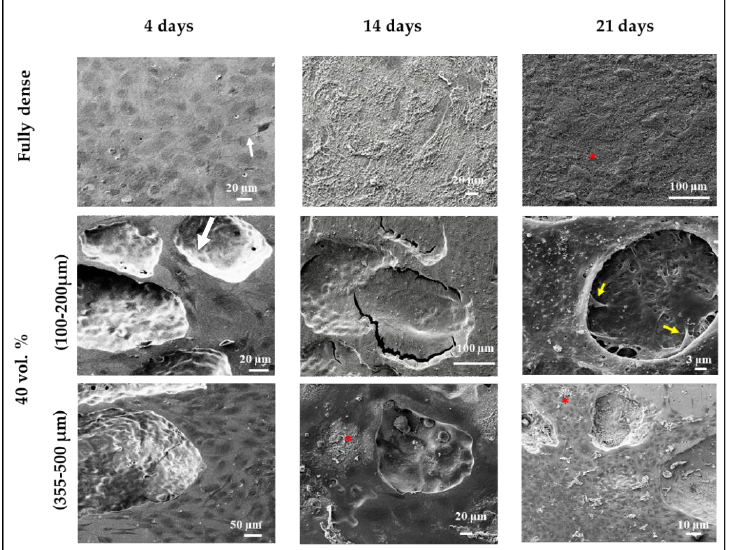
Figure 6. SEM micrographs of MC3T3 cell morphology at 4, 14 and 21 days of growing on the surface fully-dense sample, sample with porous 40 vol.% (100–200) µ m and 40 vol.% (355–500) µ m. Cell–cell interaction (white arrow), cell-surface junction (yellow arrows) and hydroxyapatite (red asterisks) are indicated in the image.